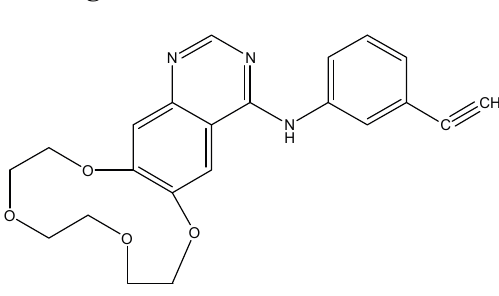
Figure 12. Structure of